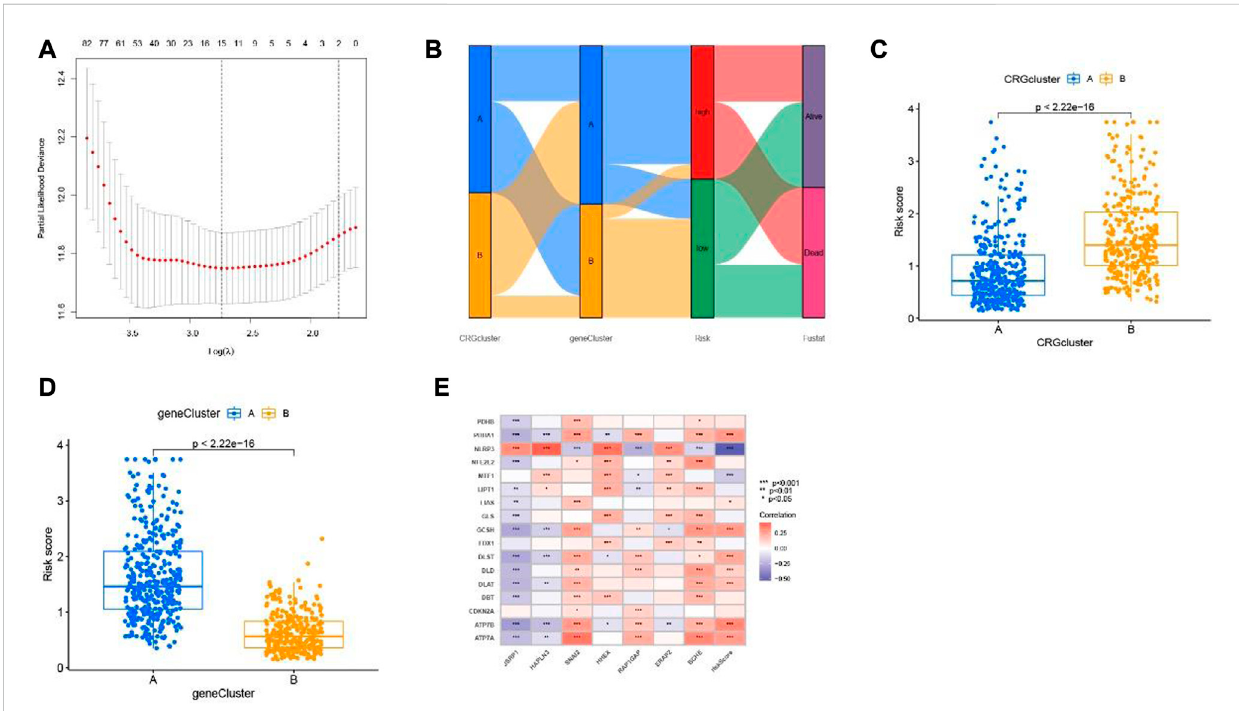
FIGURE 6 Cuproptosis-related differential genes risk prognostic model. (A) LASSO Cox regression analysis showed cuproptosis-related differential genes. (B) Sankey plot of two risk group anlysis. (C) two cuproptosis subtypes and (D) two gene clusters. (E) Association between cuproptosis-related genes and seven cuproptosis-related differential genes constructed the